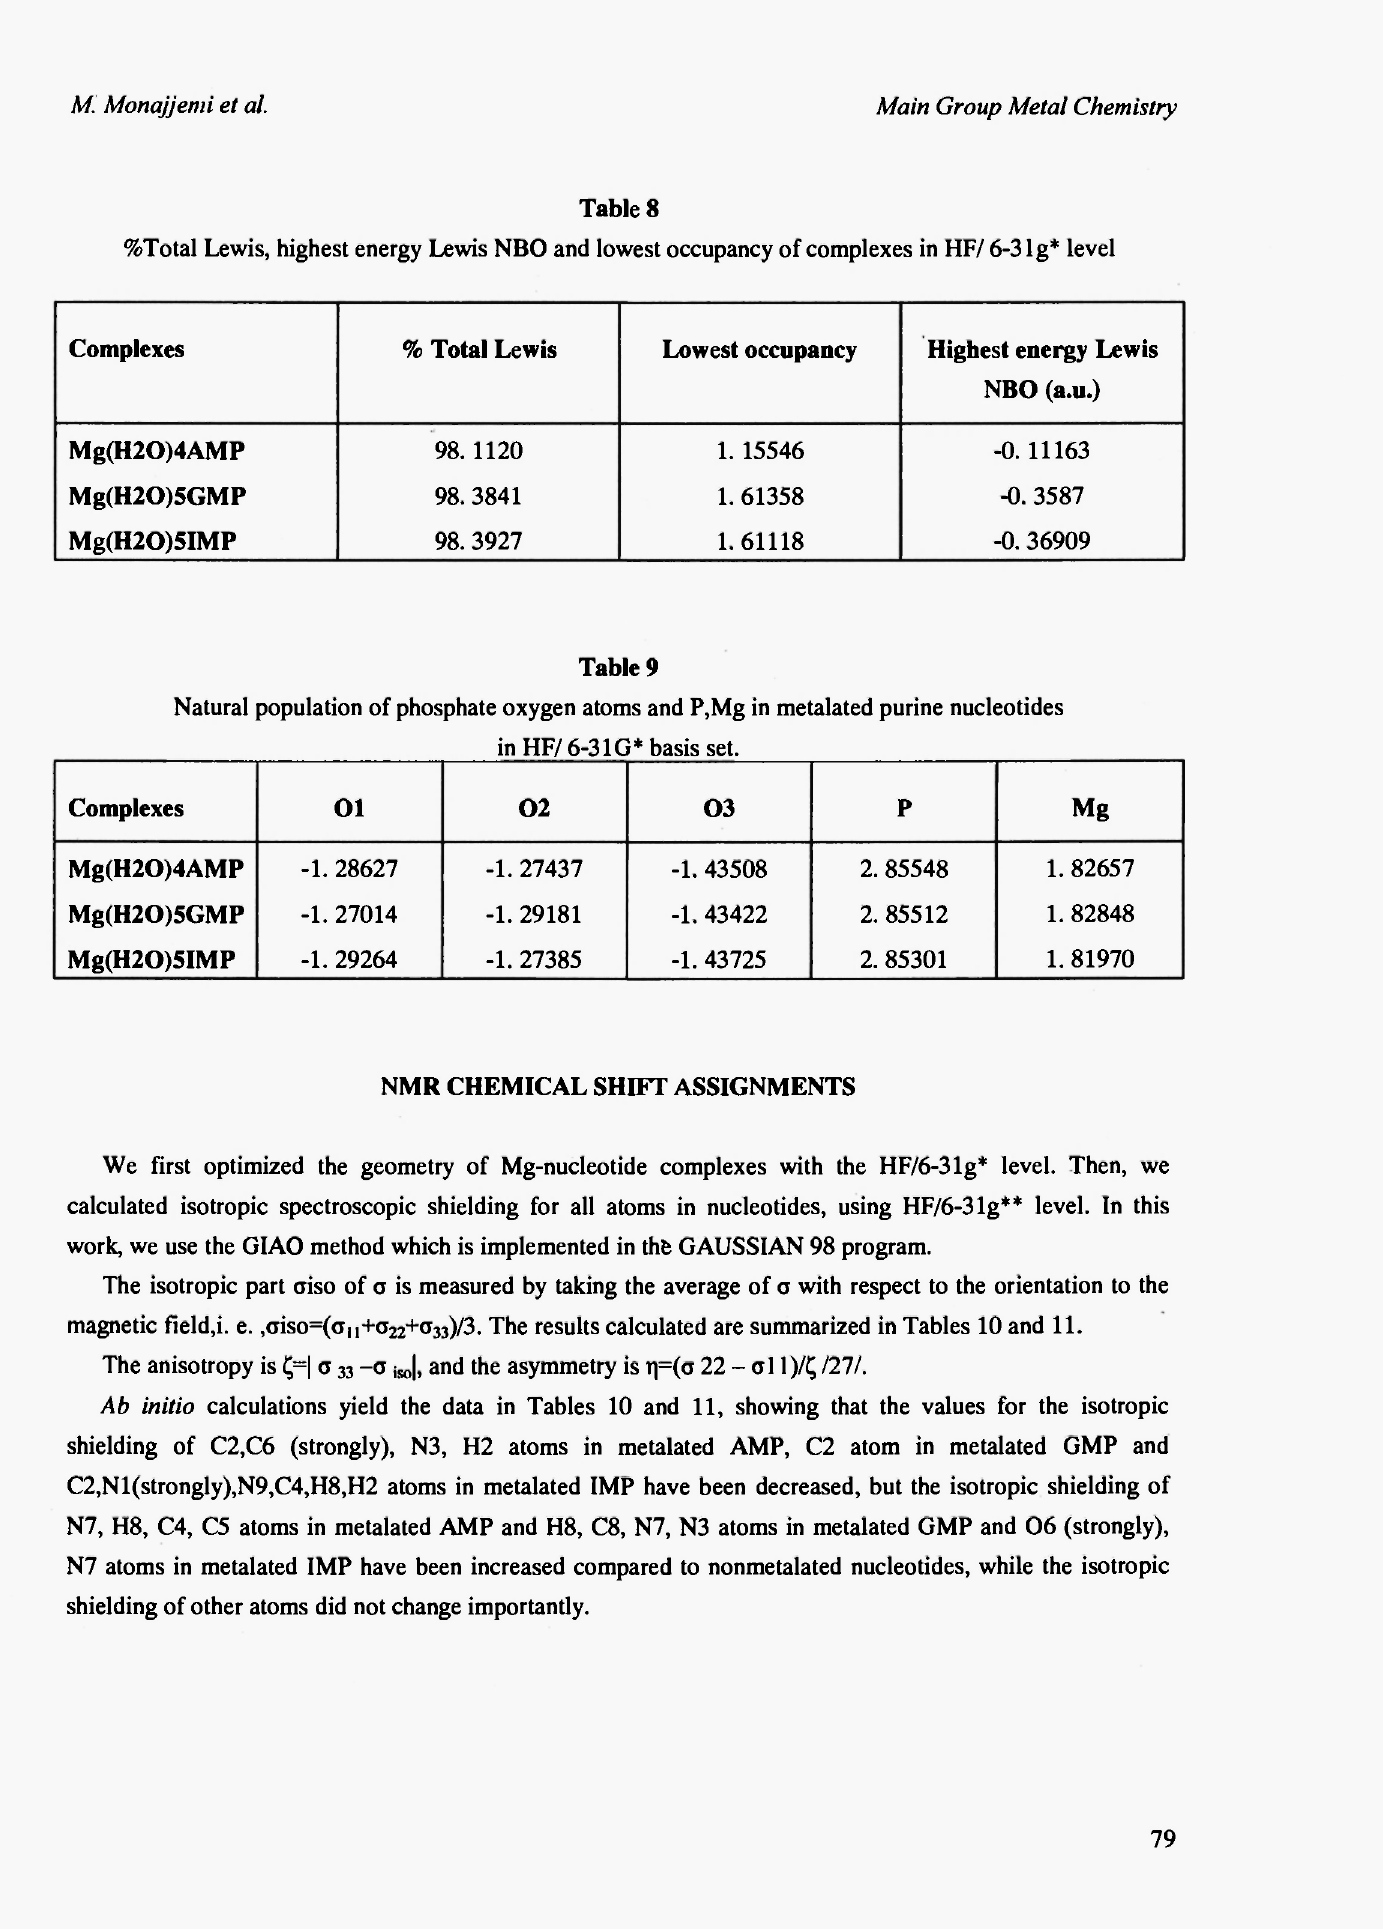
%Total Lewis, highest energy Lewis NBO and lowest occupancy of complexes in HF/ 6-3 lg* level